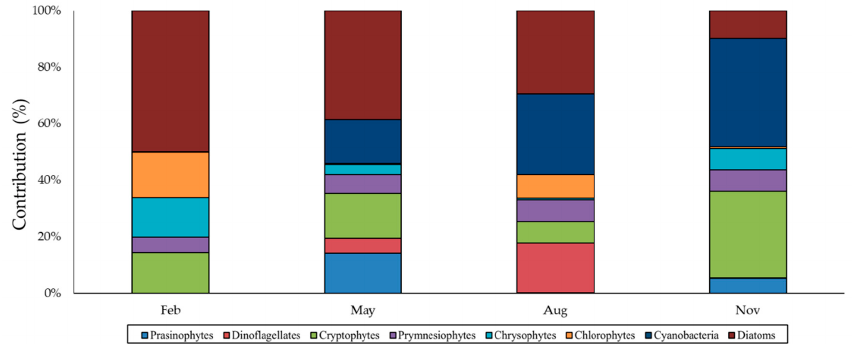
Figure 6. Seasonal contributions of phytoplankton communities averaged from all the stations for each cruise period in the northern East China Sea, 2018.